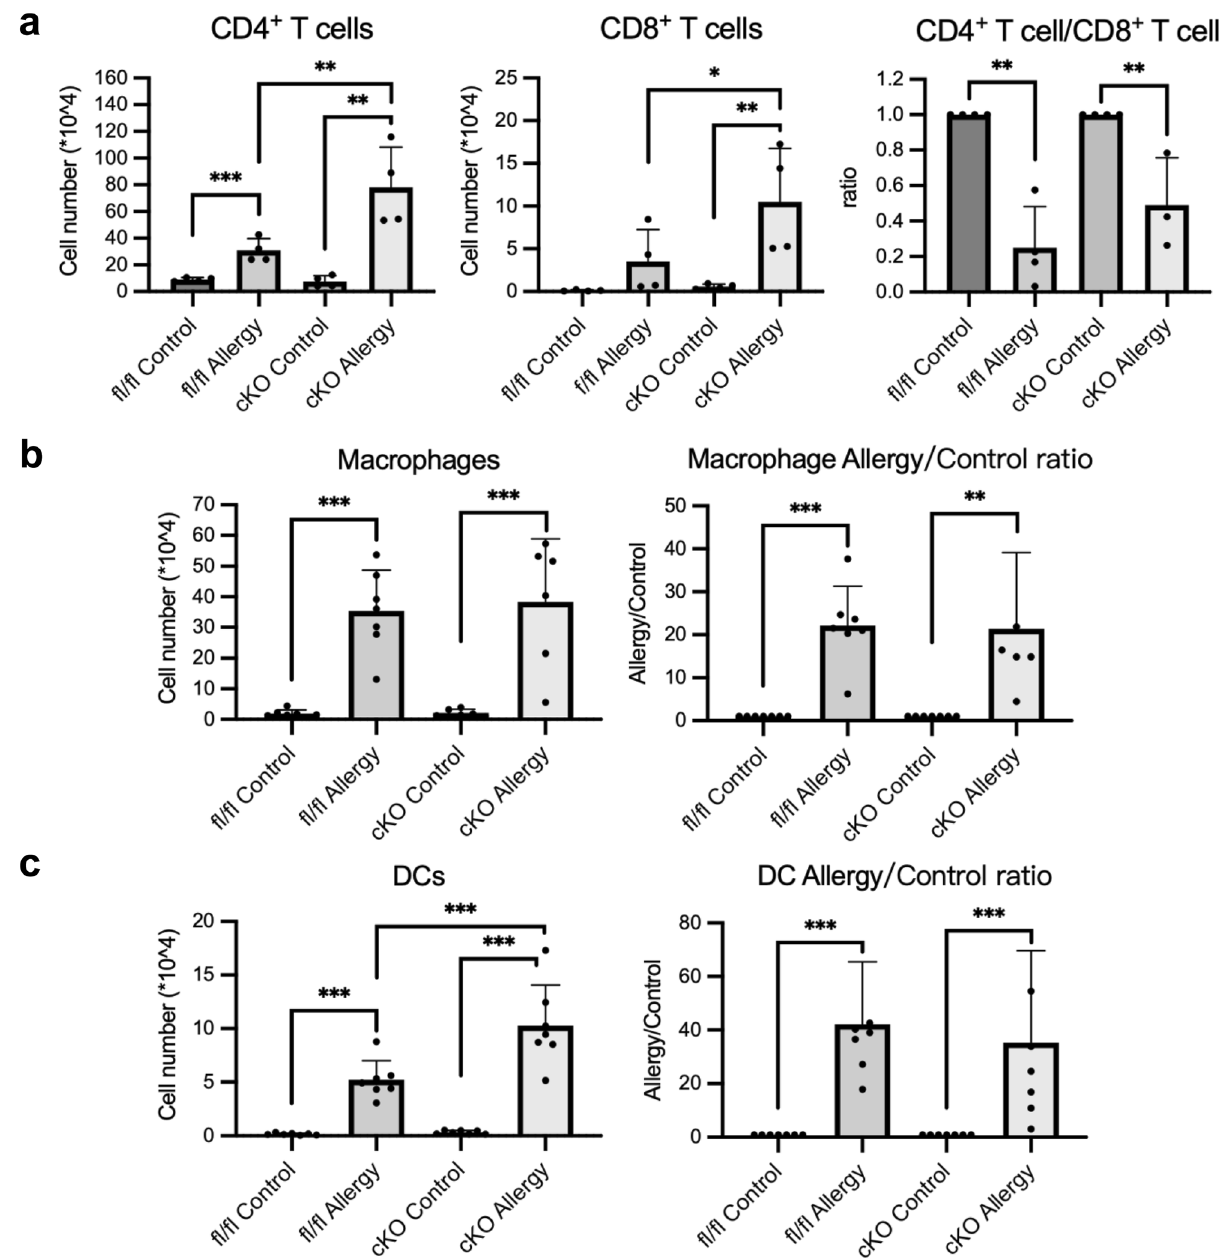
Fig. 6 The number of in fi ltrated immune cells is altered upon Sema3A deletion. a The populations of CD4 + T cells (left panel) and CD8 + T cells (middle panel) as well as the CD4 + T cell/CD8 + T cell ratio (right panel) are shown. Data are shown as mean ± SD of 4 mice/group. b The populations of macrophages (left panel) as well as the macrophage Allergy/Control ratio (right panel) are shown. Data are shown as mean ± SD of 7 mice/group. c The populations of DCs (left panel) as well as the DC Allergy/Control ratio (right panel) are shown. Data are shown as mean ± SD of 7 mice/group. Data are shown as mean ± SD and are representative of at least three independent experiments. * p < 0.5, ** p < 0.01, *** p < 0.001. Two independent samples t -test and One-Way ANOVA with LSD. Supplementary Data and p values are provided as a Supplementary Data fi